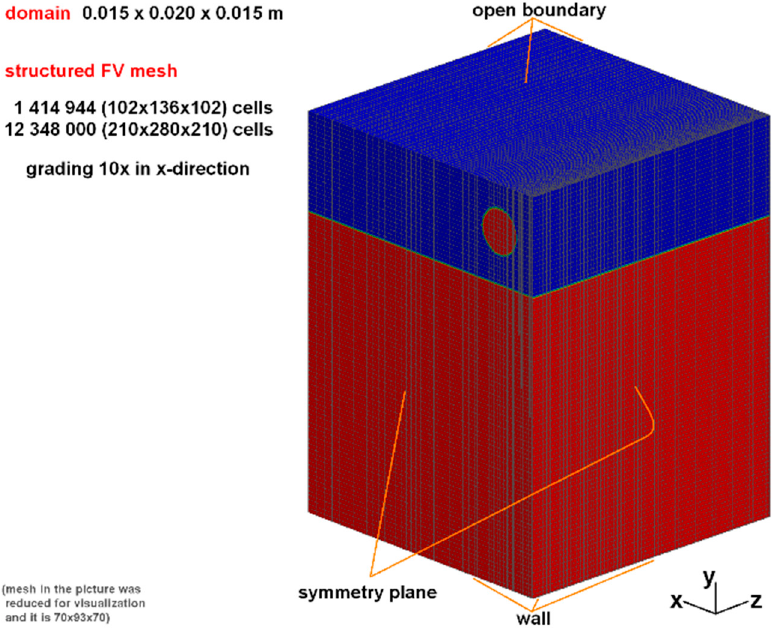
Figure 1. Domain dimensions, boundary conditions, and mesh details.